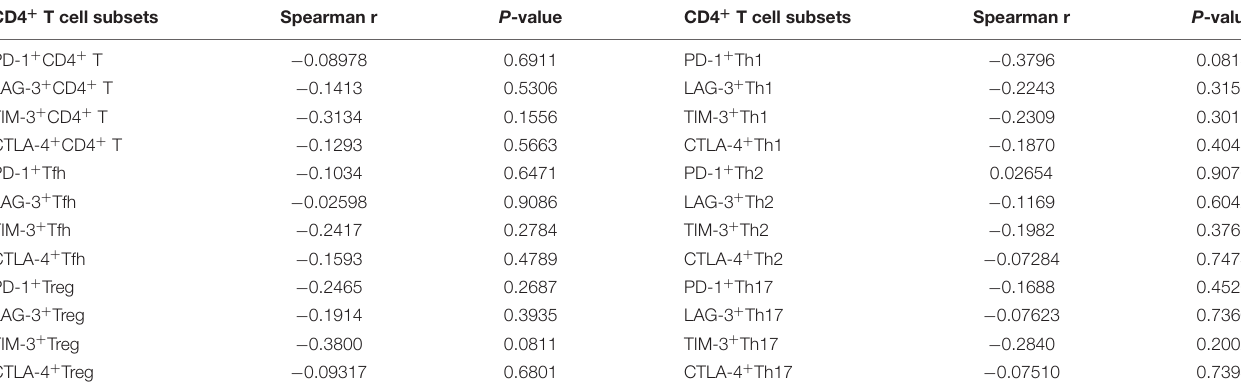
TABLE 2 | The correlation of immune checkpoint molecules on CD4 + T cell subsets and serum HBsAg levels from 22 chronic ASCs with HBeAg-negative. CD4 + T cell